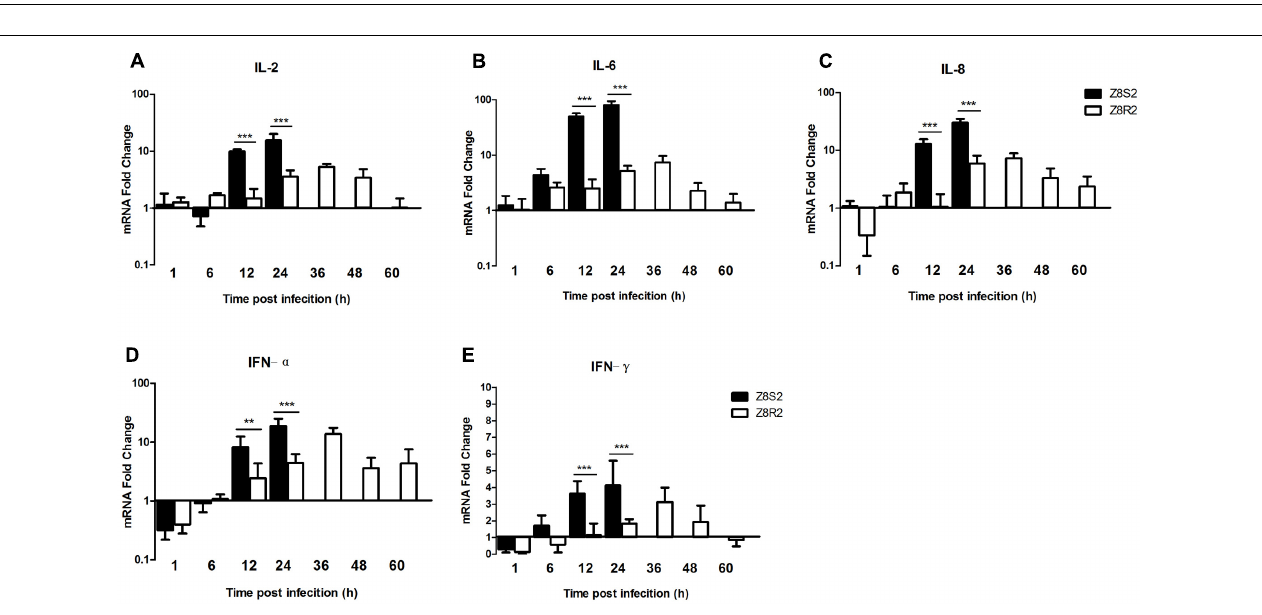
FIGURE 5 | Expression of PRRs in livers of Z8S2 and Z8R2 groups of ducklings infected with DHAV-3. Fold changes of TLR3 (A) , TLR4 (B) , TLR7 (C) , RIG-I (D) , and MDA5 (E) were calculated using the 2 - (cid:49)(cid:49) CT method. Groups Z8S2 and Z8R2 were compared for statistical significant differences using two-way ANOVA followed by Student’s t -test. For group Z7, the samples used for detection of serum collection were employed. For groups Z8S2 and Z8R2, the samples used for detection of viral load were employed except those collected between 36 and 60 h after infection in group Z8S2. ∗ P < 0.05; ∗∗∗ P < 0.001.